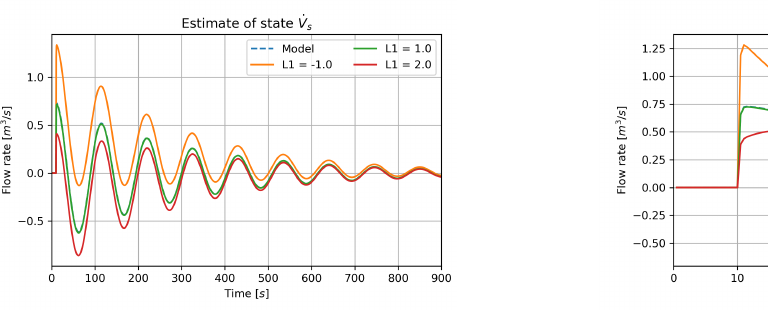
Figure 6: Observer behavior when both measurement x 1 and x 3 are injected. Gain L 1 is varied to study it’s effect on